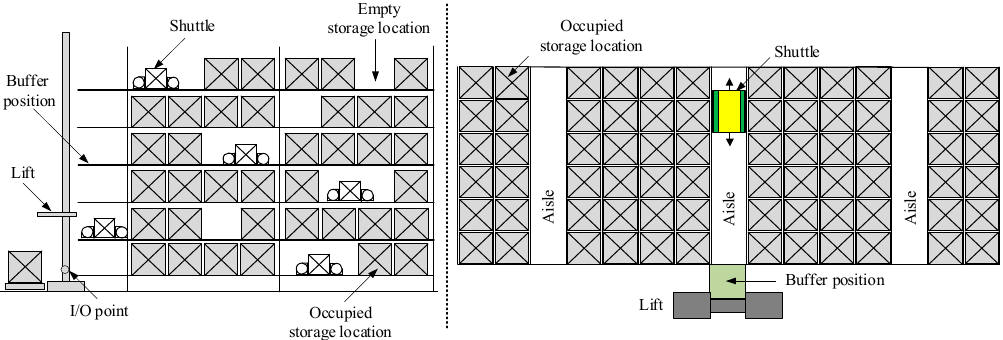
Figure 1. Schematic diagram of the double-deep multi-tier shuttle warehousing system. According to the structure of a double-deep SR, it has a higher space utilization than a single-deep SR. However, rearrangement operations will increase the retrieval task time, thereby reducing the system efficiency. According to the introduction of the FEM